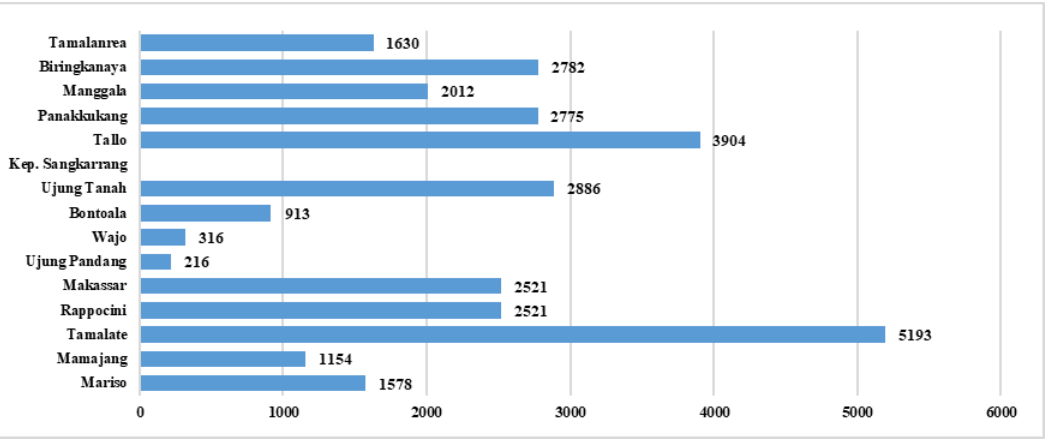
Figure 4. Number of Poor Residents in Makassar City in 2019.